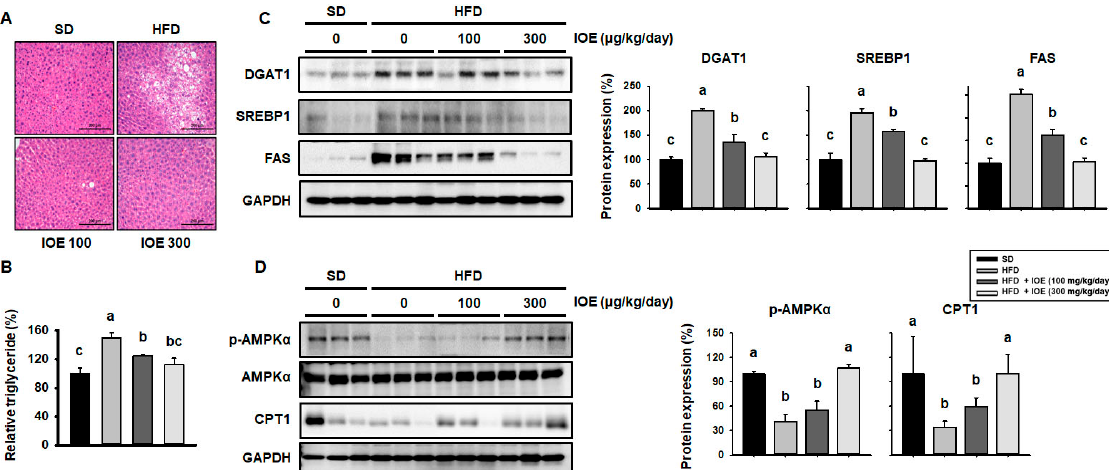
Figure 6. IOE treatment reduces hepatic lipid accumulation and regulates expression of proteins involved in lipogenesis and oxidation in HFD-induced obese mice. ( A ) Representative H&E-stained liver sections from mice fed a HFD ± IOE for 6 weeks. ( B ) Hepatic TG content. Protein levels of lipogenic genes (DGAT1, SREBP1, and FAS) ( C ) and β -oxidation genes (AMPK α and CPT1) ( D ) after HFD feeding ± IOE treatment for 6 weeks. Data are expressed as mean ± S.D ( n = 6). Values with different letters are significantly different; p < 0.05 (a > b > c). DGAT1, diglyceride acyltransferase 1. SREBP1, sterol regulatory element-binding protein 1. FAS, fatty acid synthase. GAPDH, glyceraldehyde-3-phosphate dehydrogenase.